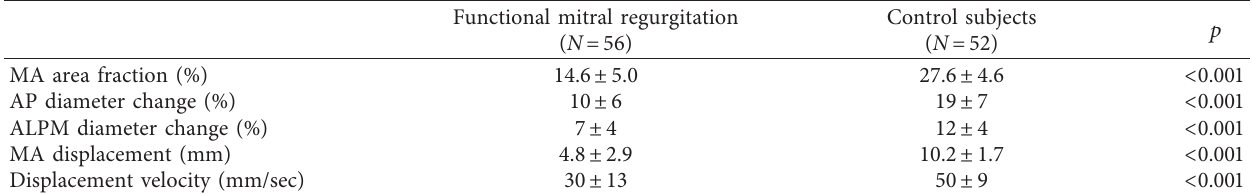
Table 4: Fractional changes of the mitral annulus parameters during the cardiac systole.